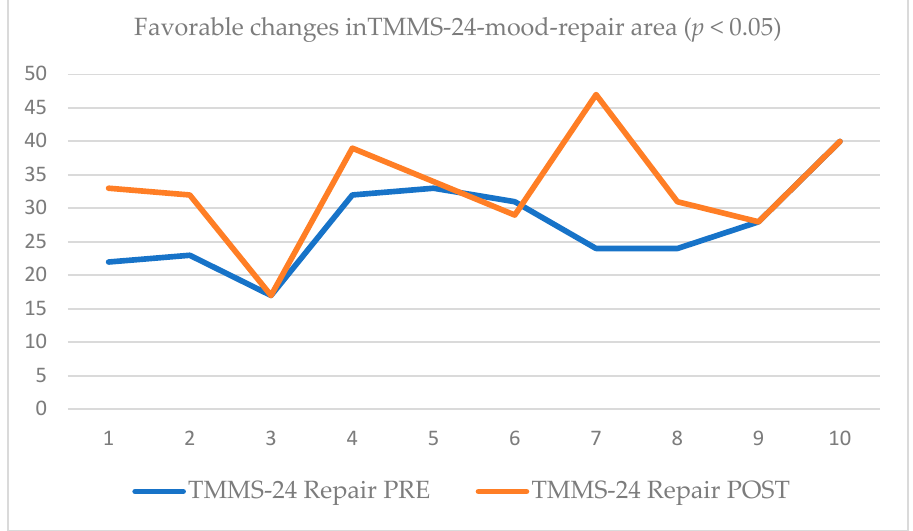
Figure 3. Pre-post scores of TMMS-24-mood-repair area.